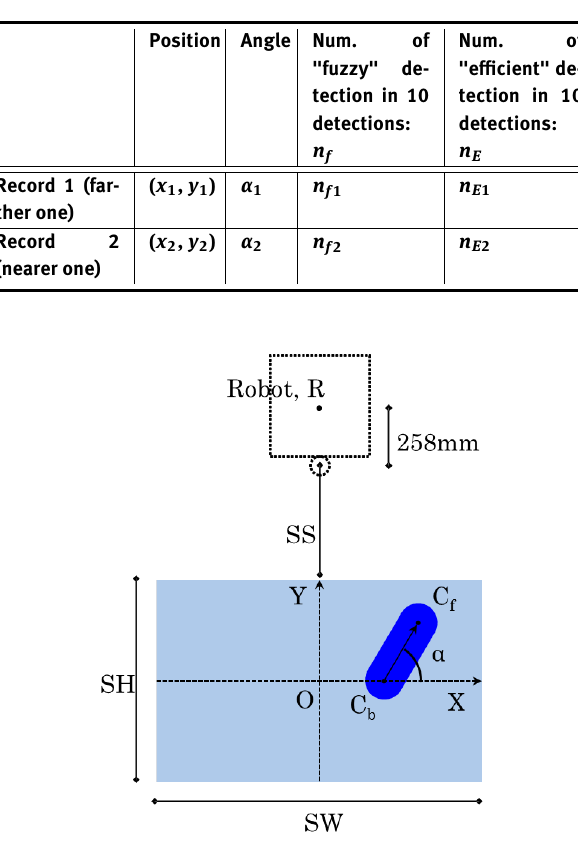
Table 3. Two Records of One Foot